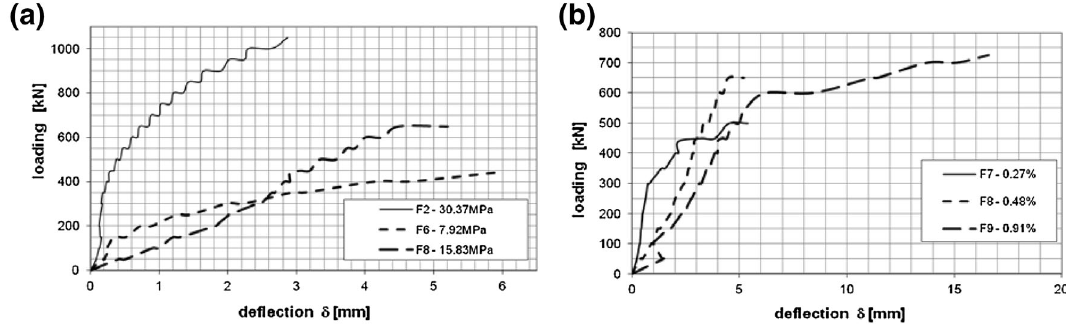
Fig. 13 Load–deflection diagram on a concrete compressive strength; b reinforcement